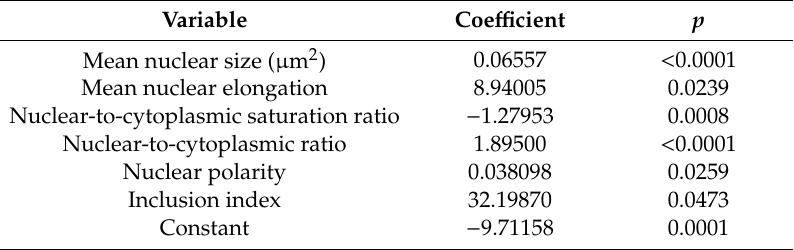
Table 3. The relationship between pathologic diagnosis and cytological characteristics in pathologic diagnosis of papillary thyroid cancer and benign follicular lesions other than follicular adenoma. Multivariate logistic regression analysis was performed using pathological diagnosis as the dependent variate (malignant: 1, benign: 0) and six cytological characteristics as independent variates ( n = 210).